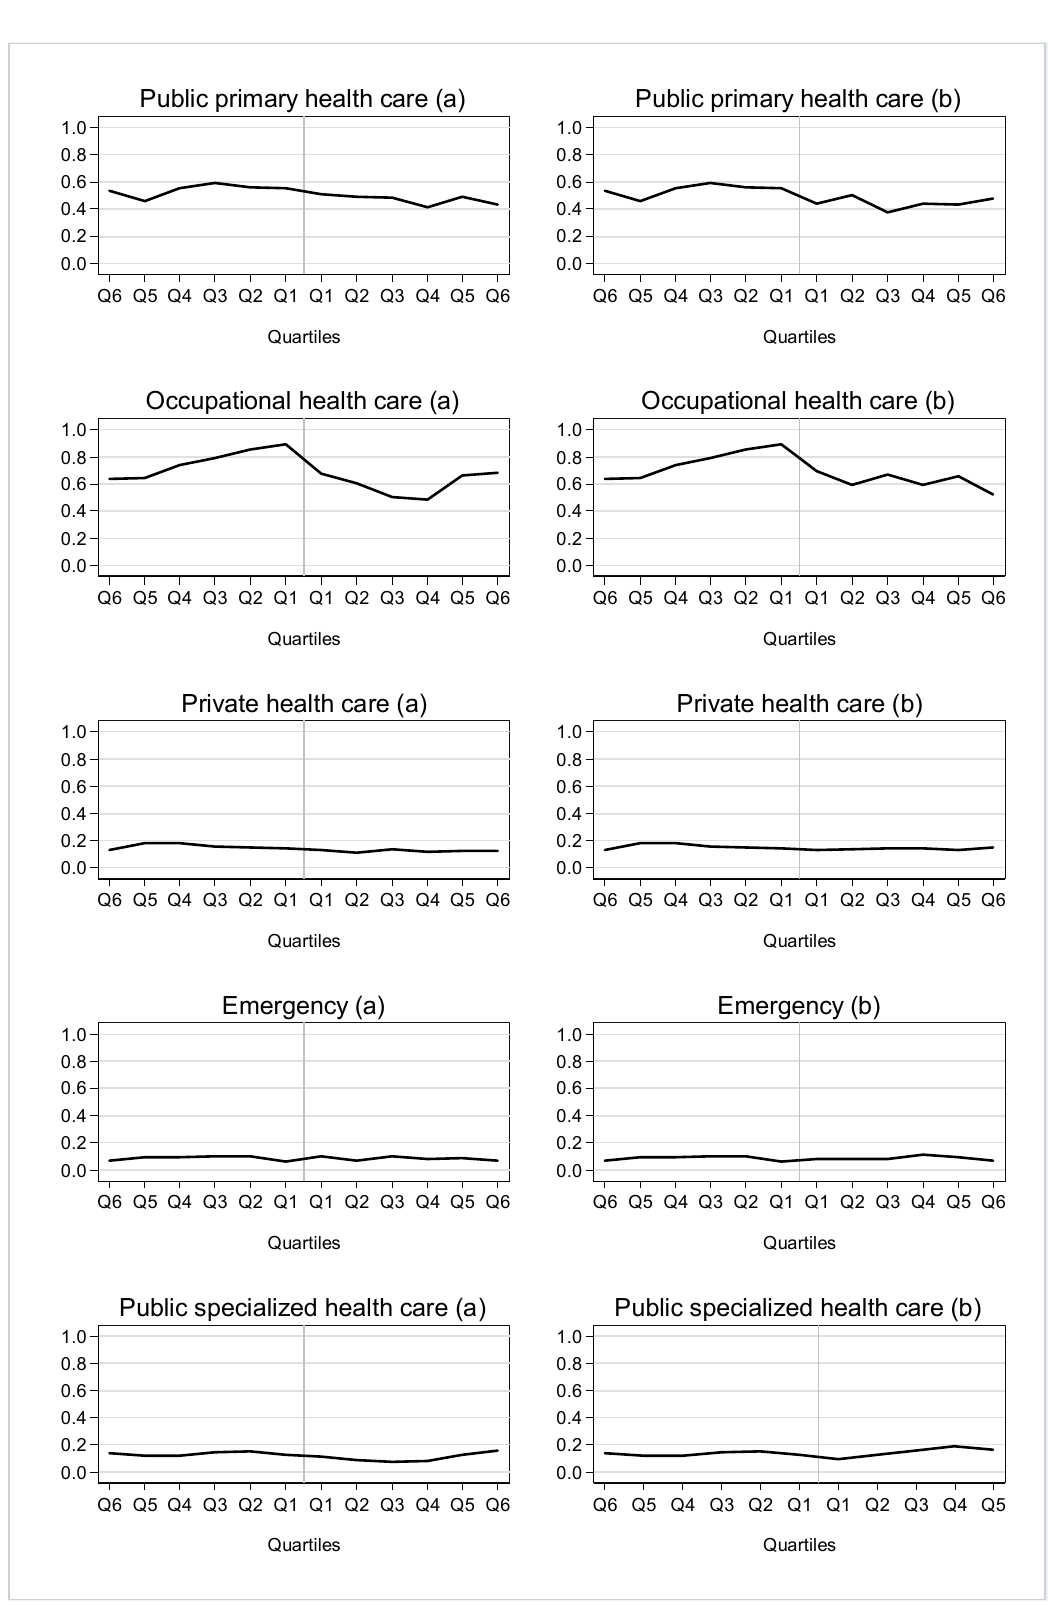
Figure 1. Number of visits in different health services among rehabilitees before the start of rehabilitation and ( a ) after the start of rehabilitation and ( b ) after the end of rehabilitation.